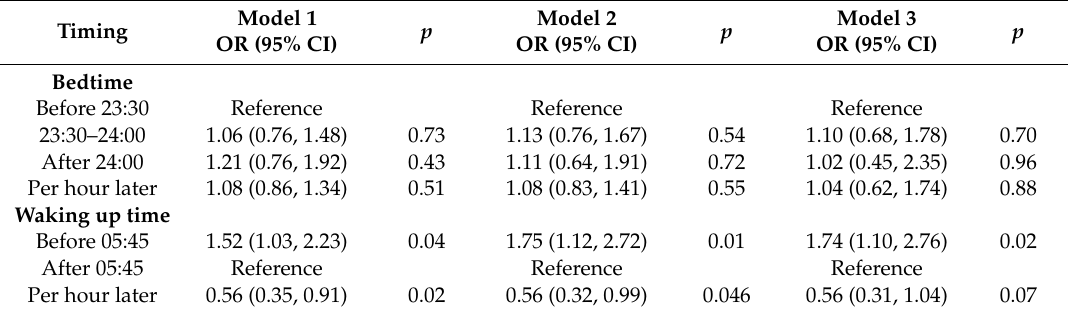
Table 3. Cross-sectional association of sleep timing with odds of overweight / obesity ( n =